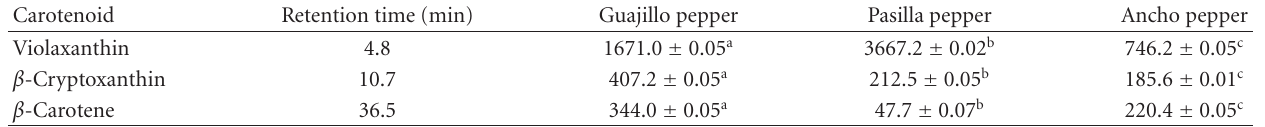
Table 3: Carotenoid contents in ancho, guajillo, and pasilla peppers determined by HPLC analysis.